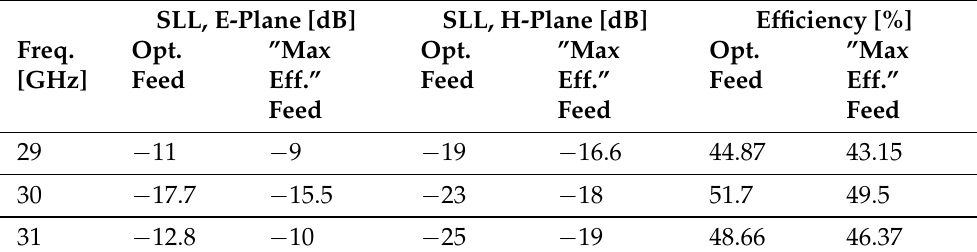
Table 2. Comparison between the proposed CRA (opt. feed) and another illuminated using a horn designed to maximize the CRA